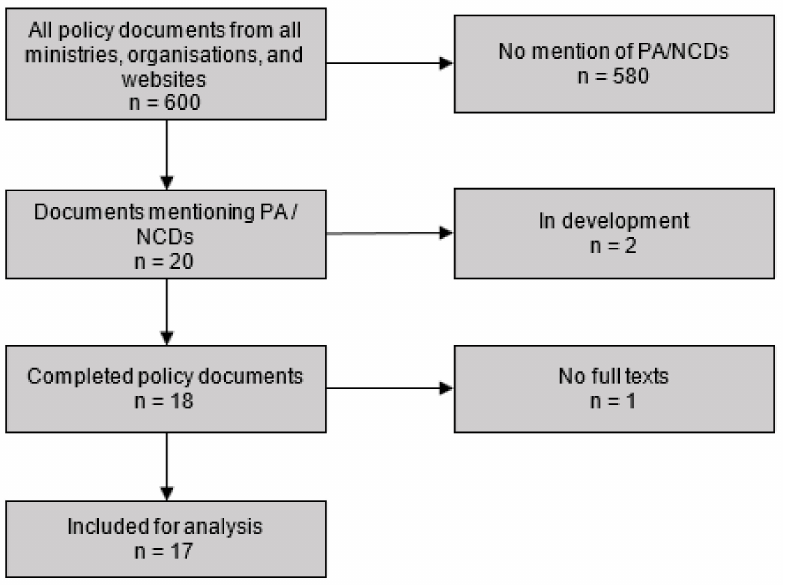
Figure 1. Flowchart of policy documents analysed for PA and NCD policies in